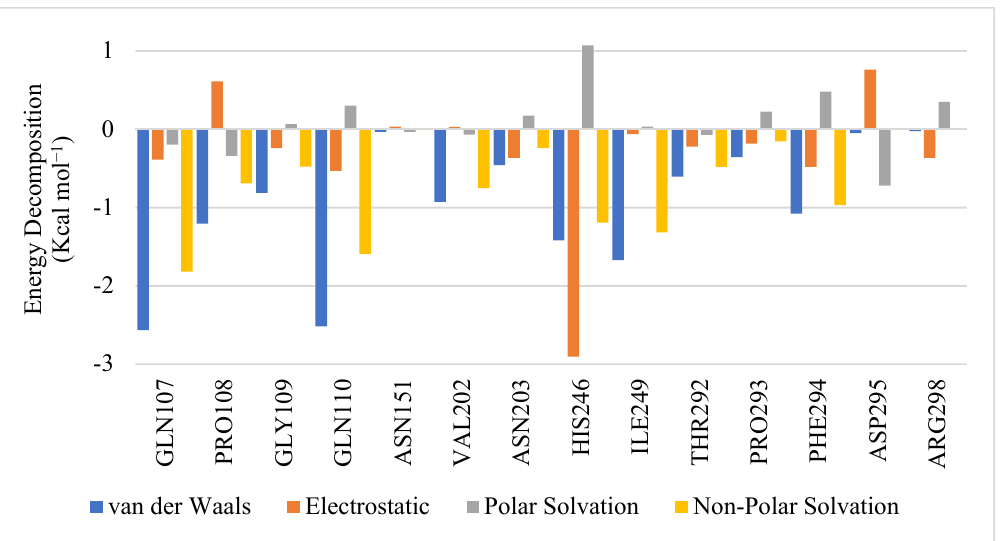
Figure 6. Pairwise energy decomposition graph illustrating residue contributions in site #2 to protein–ligand (GR04) complex.